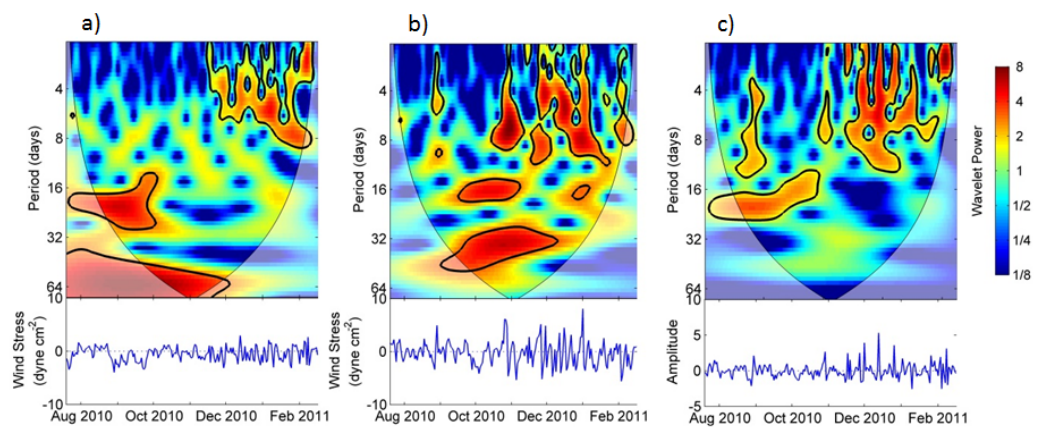
Figure 4. Wavelet power spectra (top) and time series plot (bottom) of along ‐ shelf wind stress ( a ; τ x ); cross ‐ shelf wind stress ( b ; τ y ); and PC1 ( c ). Wavelet power is normalized by the variance of each time series.